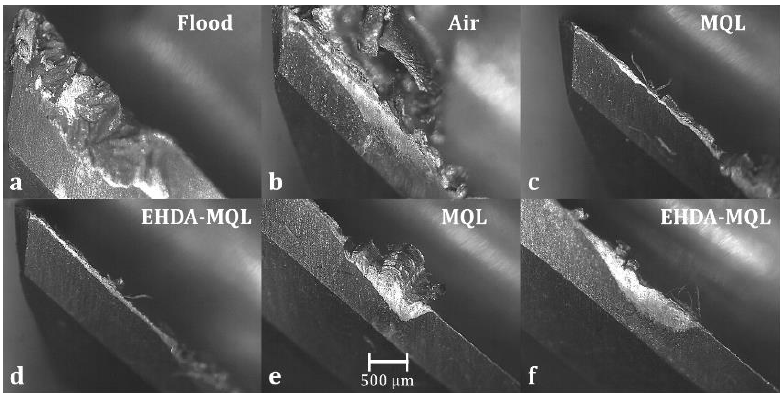
Figure 8. Cutting tool flank face at the end of tool life in each experiment.